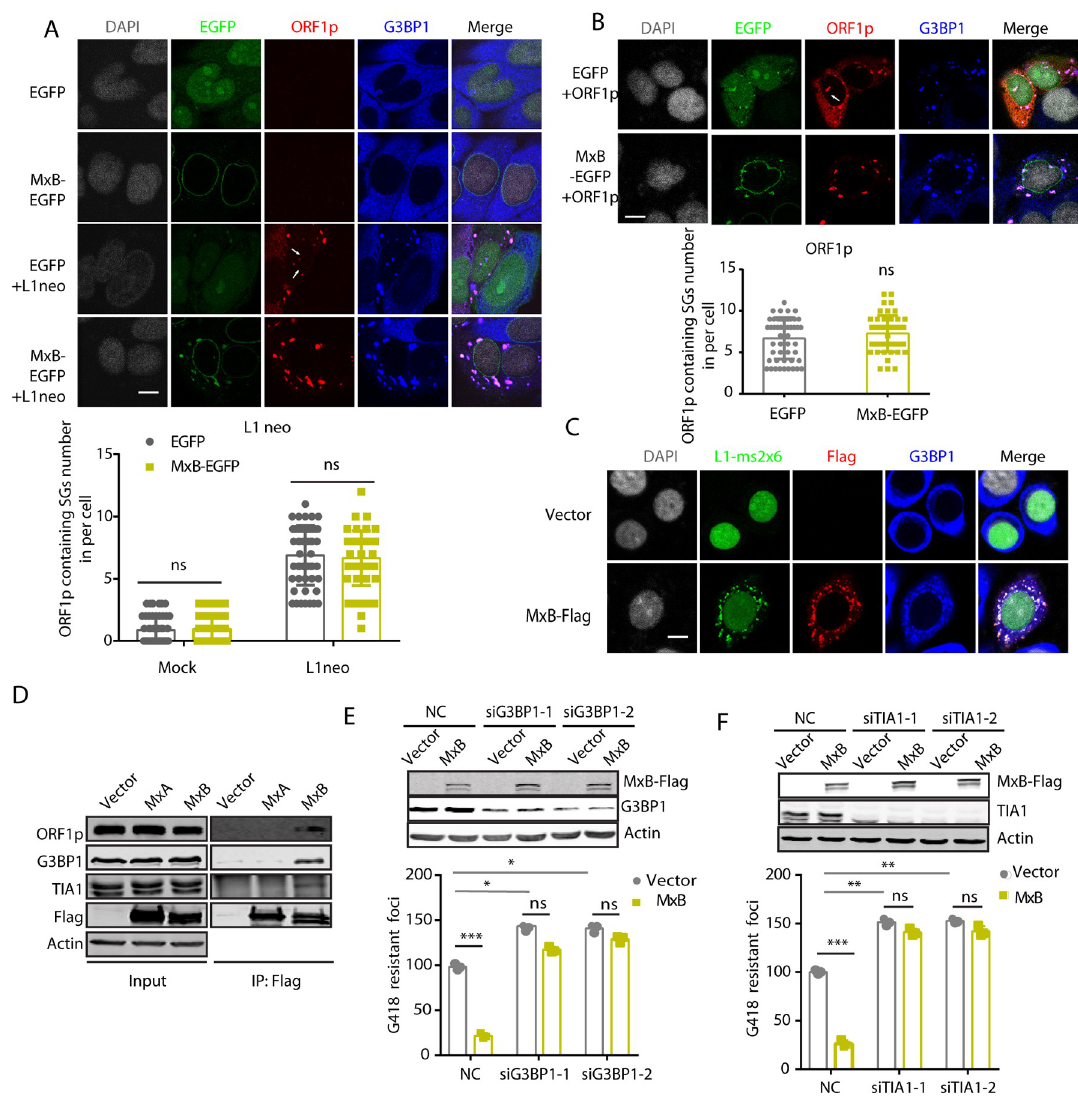
Fig 4. Inhibition of LINE-1 by MxB depends on the stress granule pathway. (A, B) Co-localization of stably expressed MxB-EGFP with ORF1p and G3BP1 in HeLa cells. ORF1p was either expressed from the transfected CMV-L1-neo RT DNA (A) or ORF1p vector DNA (B). White arrows indicates nuclear ORF1p. ORF1p/G3BP1-containing SGs were scored in more than 50 cells for each treatment. The average number of ORF1p-containing SGs per cell is presented in the bar graph (mean ± SEM; paired t -test). (C) Co-localization of LINE-1 RNA, MxB-Flag and G3BP1 in cells transfected with MxB-Flag (500 ng), LINE-1-ms2x6 (750 ng) and MS2-GFP (250 ng) DNA. The LINE-1 RNA bears 6 copies of MS2-binding sites which are bound by MS2-GFP and detected as cytoplasmic puncta. (D) Co-immunoprecipitation to detect the association of MxB with ORF1p in HEK293T cells which were co-transfected with CMV-L1-neo RT and MxA-Flag or MxB-Flag DNA. (E, F) Effects of G3BP1 (E) or TIA1 (F) knockdown on MxB inhibition of LINE-1 in HeLa cells which were co-transfected with MxB and CMV-L1-neo RT DNA. The number of G418-resistant cell colonies was determined for each condition. The results are presented in the bar graphs (mean ± SEM; paired t -test). ns, not significant. �� denotes P < 0.01; ��� , P <